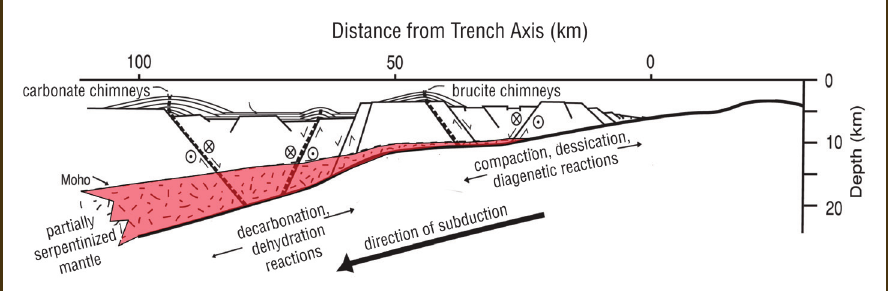
Figure 7. Reddish area indicates approximate position of the Samail mantle section during thrusting over the metamorphic sole and metasediments of the Hawasina Group. Study of alteration of hanging